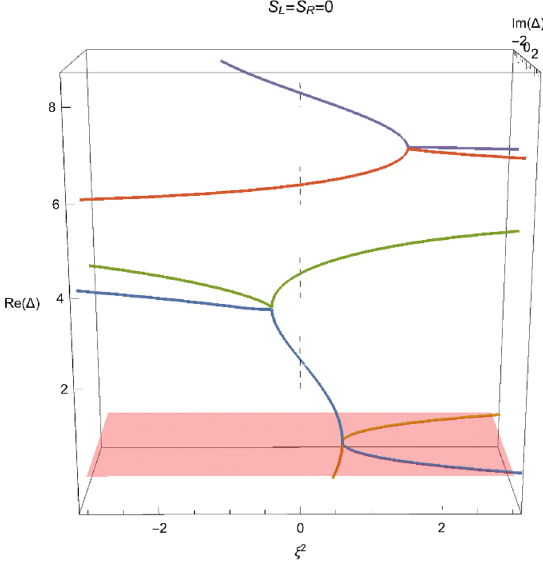
Figure 16 . The conformal dimensions of the one-magnon operators at twist angle (cid:18) = 2 : 0 and real (cid:24) 2 . The dimensions start real for small (cid:24) 2 and then split into pairs of complex conjugate (cid:1)’s. We see how the scaling dimensions of di(cid:11)erent operators are connected to each other through analytic continuation in the complex (cid:24) 2